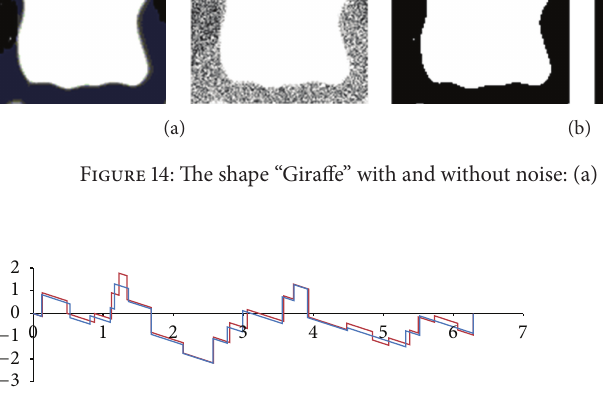
Figure 15: The periodical angle function of the shape “Giraffe” with and without artificial